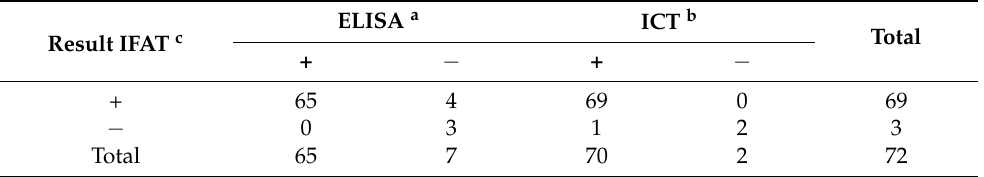
Table 3. Comparison of IFAT with ELISA and ICT for detection of antibodies to B. bovis in field serum